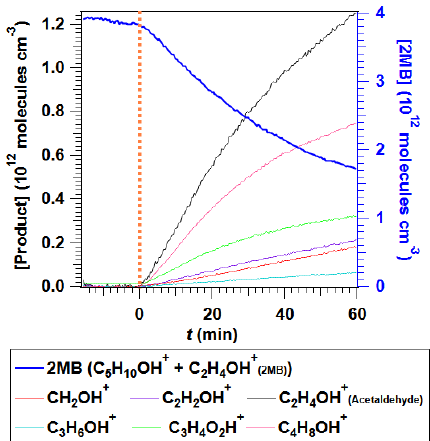
Figure 7. FTIR spectra used in the identification of the products in the Cl reaction of 2MB. The top panel shows the initial spec- trum, the central panel shows the spectrum obtained after 50min of Cl reaction, with the features of 2MB subtracted, and the bottom panel shows the residual spectrum after the subtraction of reaction products shown in Fig. S6.